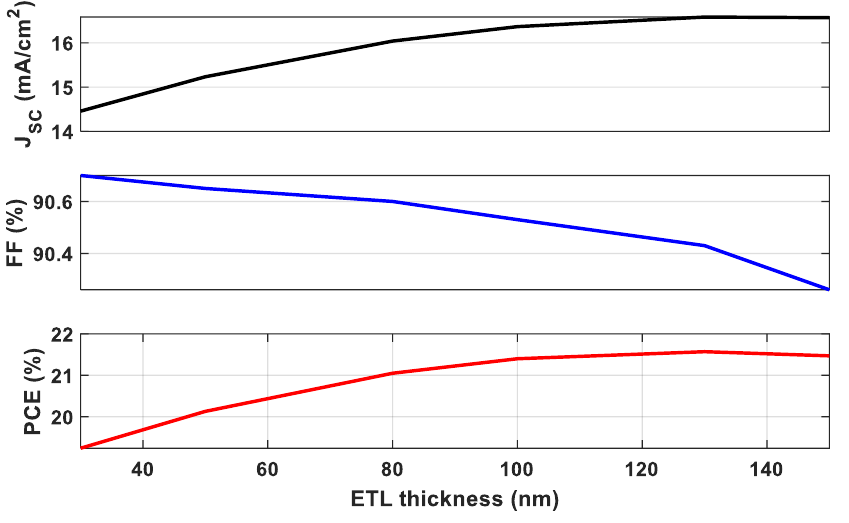
Figure 9. Effect of WS 2 thickness on the performance parameters.